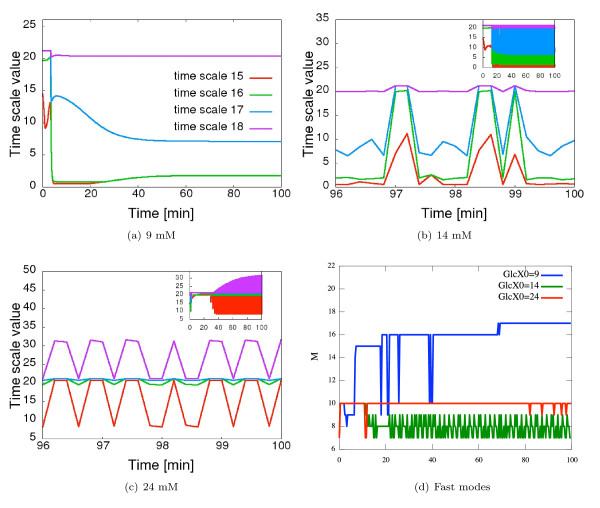
Time evolution of the time scales 15 to 18 in the three dynamic regimes (a)-(c) at concentrations of [Glcx]0 from time t = 0 min to t = 100 min. In Figure (b), (c) the subinterval from t = 96 min is drawn to a larger scale. (d) Time evolution of the number of fast modes M in the three different dynamic regimes.